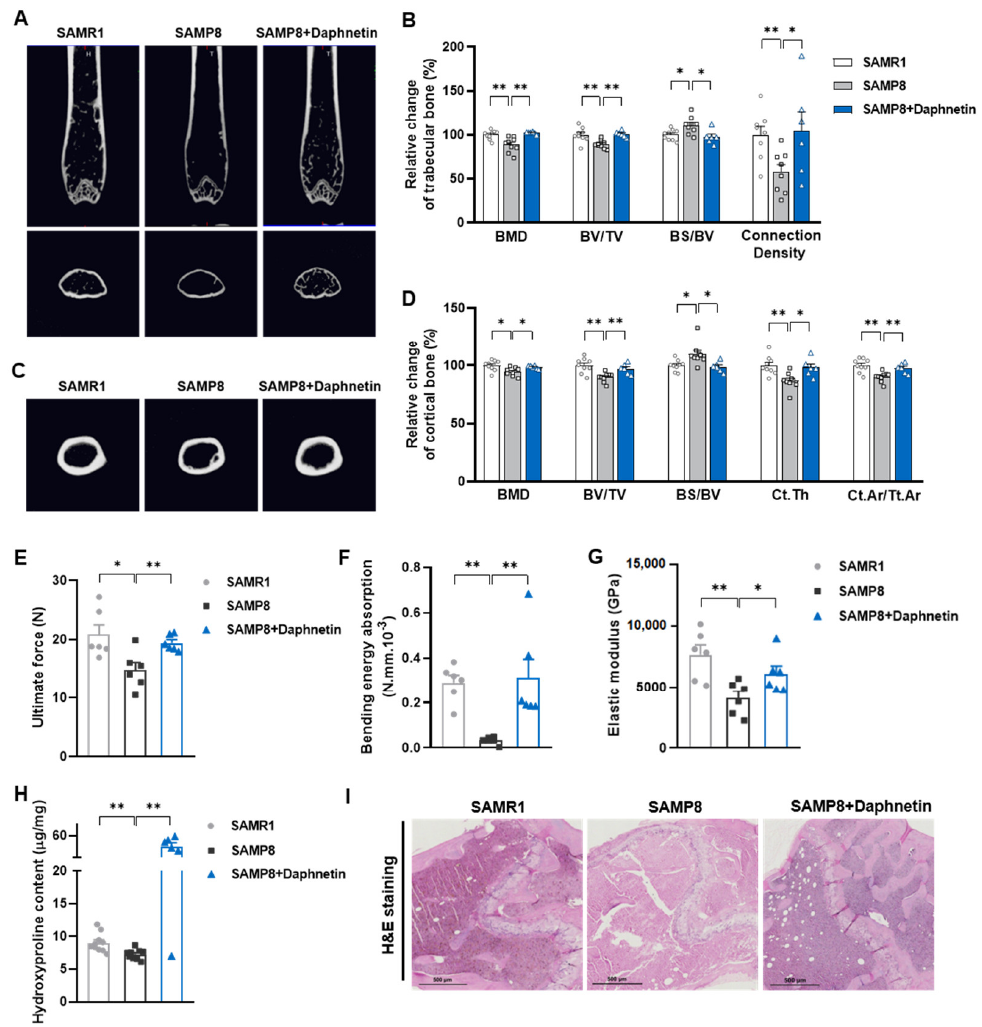
Figure 1. Protective effects of daphnetin against senile osteoporosis in SAMP8 mice. ( A ) Micro-CT images of trabecular bone in distal femur. ( B ) Trabecular bone mineral density (BMD), bone volume per tissue volume (BV/TV), bone surface to bone volume ratio (BS/BV), and connection density were calculated from the micro-CT data. ( C ) Micro-CT images of cortical bone in mid-diaphysis femur. ( D ) Cortical BMD, BV/TV, BS/BV, cortical thickness (Ct. Th), and cortical area to total area ratio (Ct. Ar/Tt. Ar) were calculated from the micro-CT data. To evaluate femoral mechanical properties, ultimate force ( E ), bending energy absorption ( F ), and elastic modulus ( G ) were determined by three-point bending test. ( H ) Hydroxyproline content of femur was determined with commercial kit. ( I ) Femur sections were prepared, and H&E staining was performed. Data are mean ±S.E.M. ( n ≥ 6); * p < 0.05; ** p < 0.01.